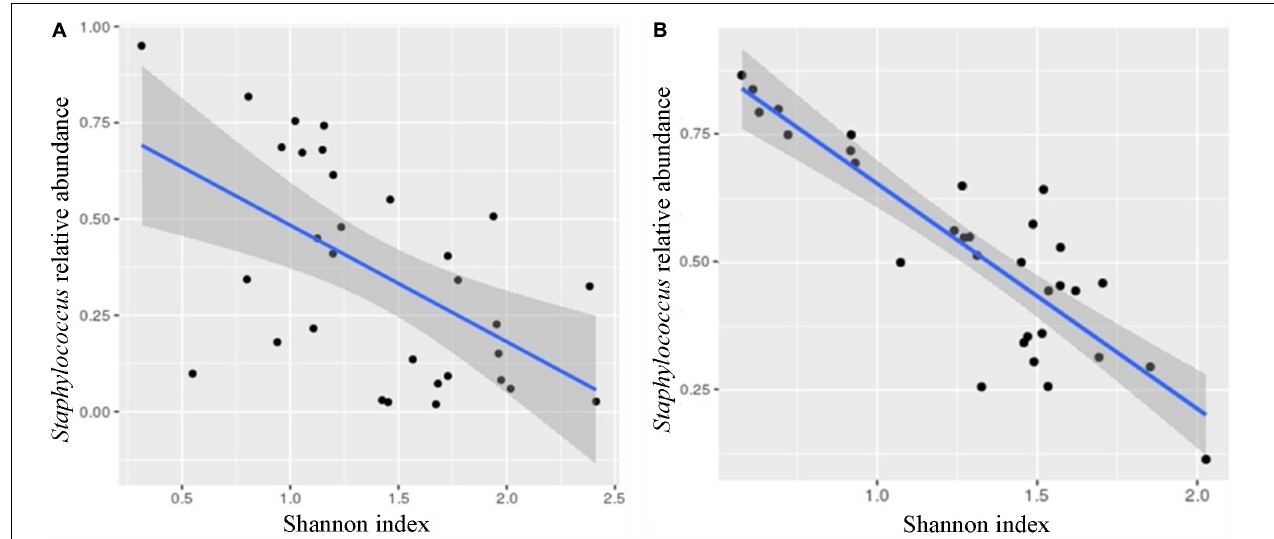
FIGURE 4 | Correlations between Staphylococcus relative abundance and Shannon diversity index. The Shannon diversity index negatively correlated with the abundance of Staphylococcus using both methods, 16S metagenomic sequencing ( A ; Otu001; Pearson’s r : –0.556, p < 0.01 ∗ ) and cultivation ( B ; Pearson’s r : –0.629, p < 0.001). ∗ p -value is not below the corrected p -value [Benjamini–Hochberg correction (FDR < 0.05) for multiple testing] and the correlation could not be considered as statistically significant. TABLE 1 | Association of factors with specific OTUs and genera detected in HMM with 16S NGS. Factor Class Number of samples Genus (OTU) LogMax mean LDA p -value Milk collection technique MANUAL